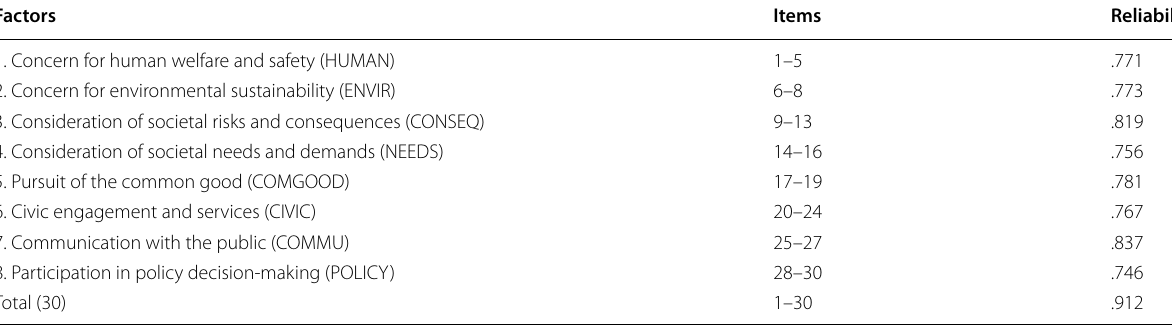
Table 2 Internal consistency reliability of the VSRoSE